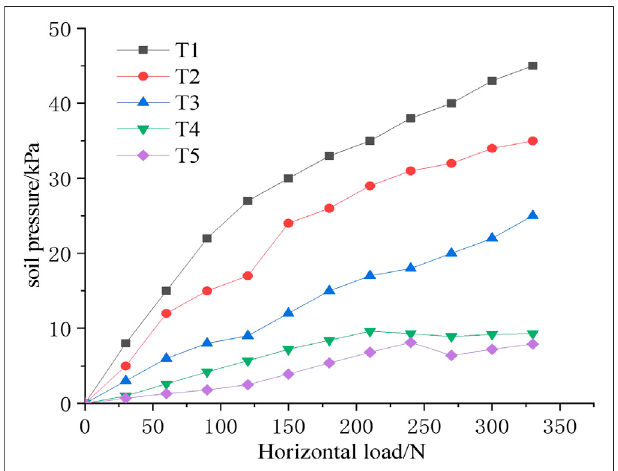
FIGURE 12 | Pile side earth pressure diagram under horizontal static